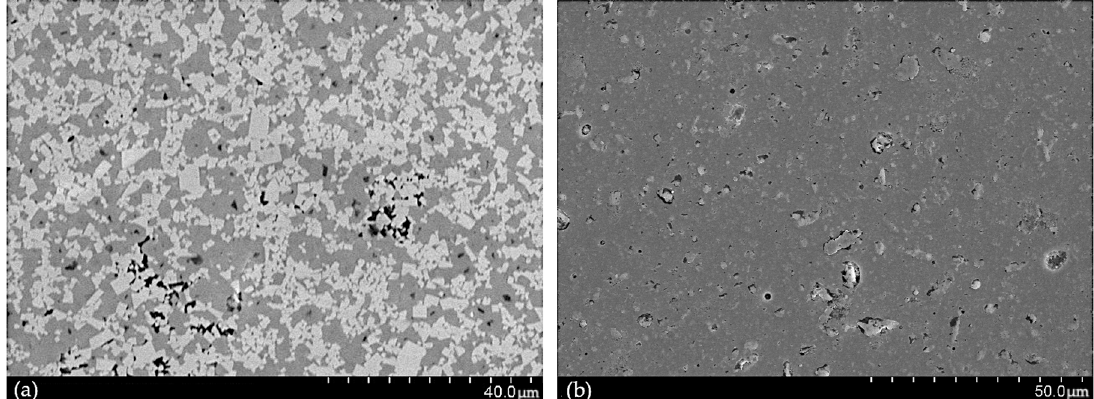
Figure 4. SEM images of the surface of the polished WC-TiC-Co uncoated sample ( a ) and AlCrSiN coated sample ( b ).